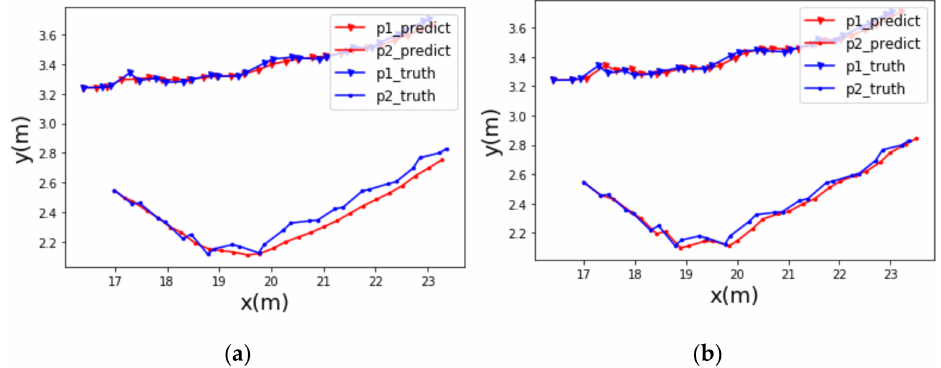
Figure 12. Birds-eye view tracking visualization of two pedestrians: ( a ) predicted positions without the speed information speed; ( b ) predicted positions with the speed